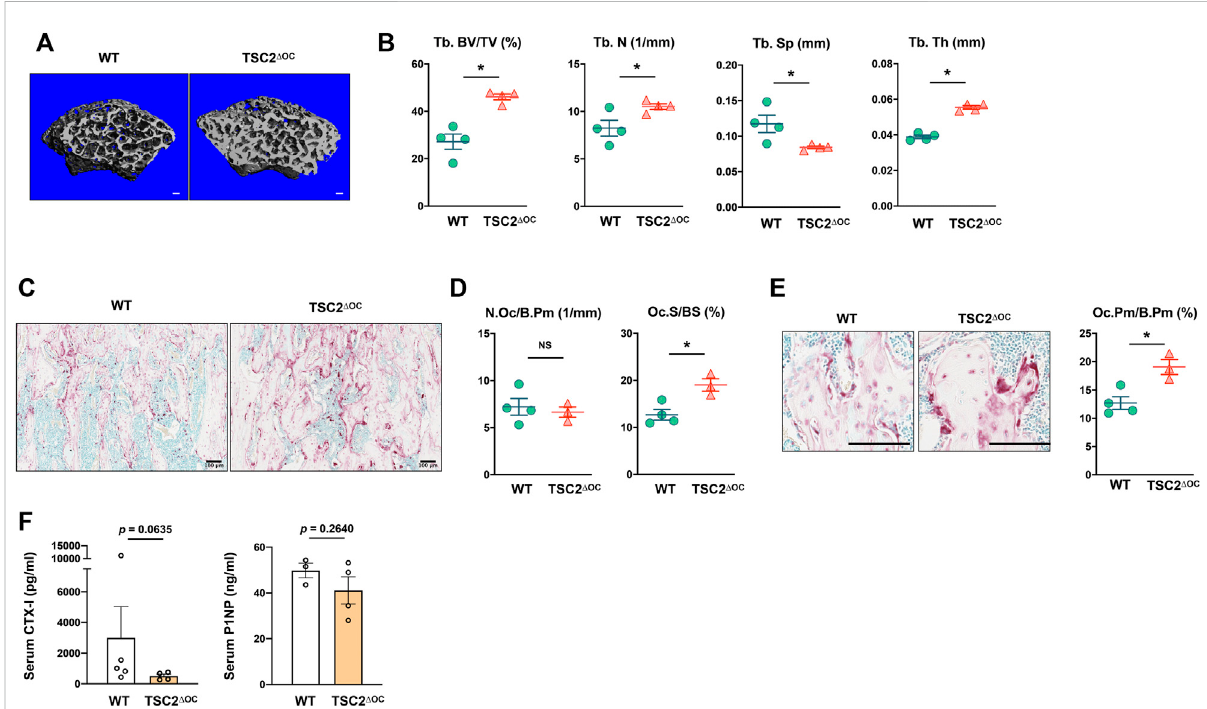
FIGURE 4 Hyperactivation of mTORC1 in osteoclasts impedes bone resorption. (A) Representative μ CT reconstructed images of the trabecular architecture of the distal femurs from 8-week-old female TSC2- fl oxed Cathepsin K-Cre (TSC2 Δ OC ) and littermate control Cathepsin K-Cre (WT) mice. (B) μ CT measurements for the indicated parameters of the trabecular bone in distal femurs. Bone volume/tissue volume ratio (BV/TV), trabecular numbers (Tb.N), trabecular thickness (Tb.Th), and trabecular space (Tb.Sp) were determined by μ CT analysis. (C) Representative images showing the TRAP-positive, multinucleated osteoclasts (red) in the coronal sections of the distal femur. (D) Histomorphometric analysis of the trabecular bone. Number of osteoclasts per bone perimeter (N.Oc/B.Pm), osteoclast surface area per bone surface (Oc.S/BS). (E) Enlarged images from (C) showing thesize ofTRAP-positive, multinucleated osteoclasts (red). Graph depictsthe sizeof osteoclasts. Osteoclast perimeter per boneperimeter(Oc.Pm/B.Pm). (F) TheconcentrationofserumCTX-IandPINPmeasuredbyELISA.Alldataareshownasmean±SEM.* p <